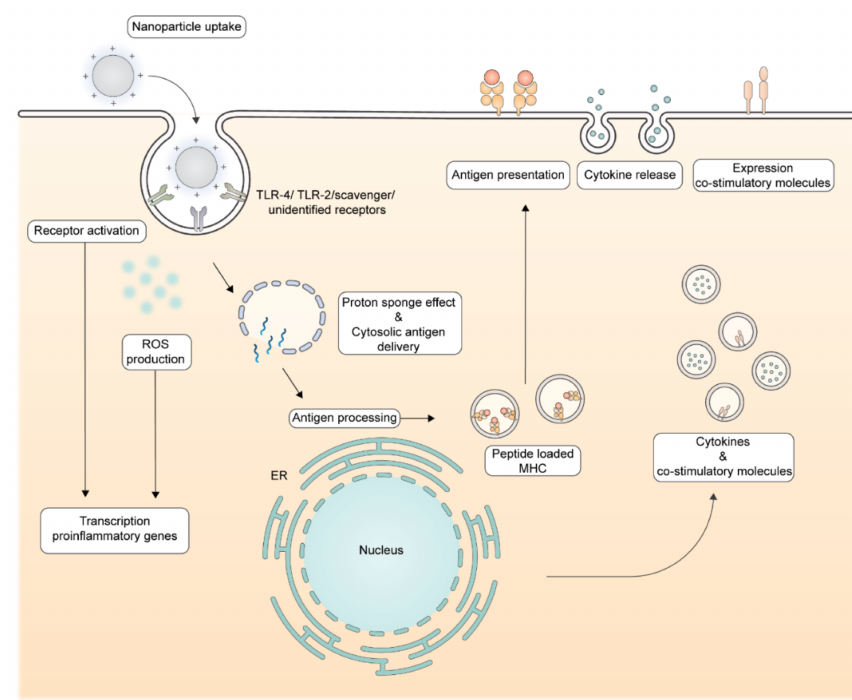
Figure 4. Molecular immune-stimulating mechanisms by cationic nanoparticles. Upon uptake, cationic nanoparticles can have immune-stimulating properties via the induction of reactive oxygen species (ROS) and receptor activation, such as the TLR-4. These pathways result in the transcription of pro-inflammatory genes, resulting in translation of proinflammatory cytokines and co-stimulatory molecules. The proton–sponge effect results in cytosolic antigen delivery, enabling the polypeptide antigen to enter the antigen processing machinery. Proteasome and peptidase mediated processing will deliver oligopeptides to be presented in MHC molecules which will be transported to the cell surface. An increase in cytosolic antigen delivery combined with the immune-stimulating properties of cationic nanoparticles results in efficient priming of antigen-specific